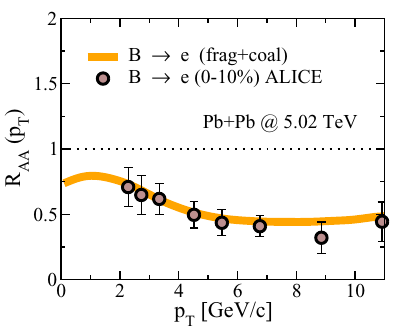
Figure 2. Nuclear modification factor R AA ( p T ) of electrons from semi-leptonic B-mesons decays at 0 10% centrality class for Pb + Pb at √ s = 5 . 02 TeV . Experimental data have been taken from Ref. −